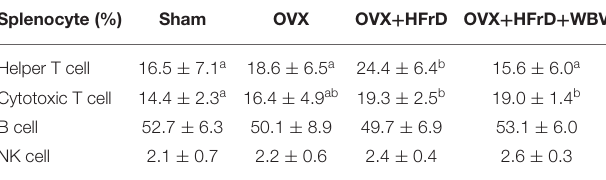
TABLE 4 | The proportion of immune cells subtypes in the